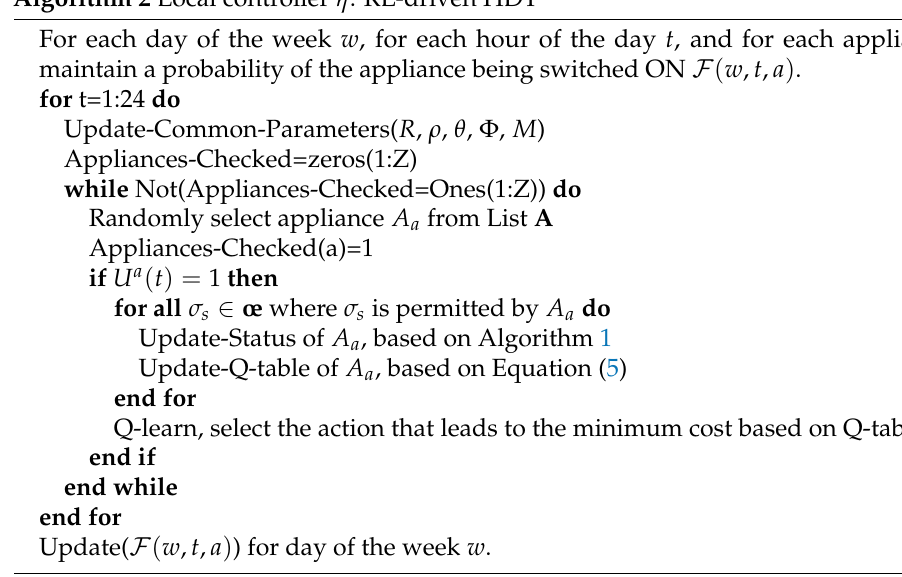
Algorithm 2 Local controller η : RL-driven